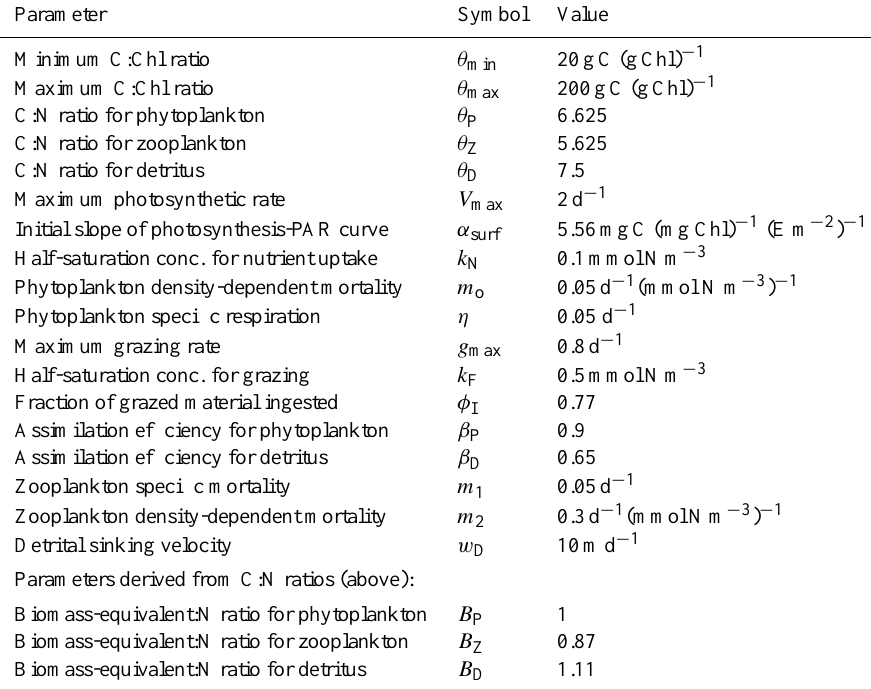
Table D1. HadOCC model parameters. Parameter